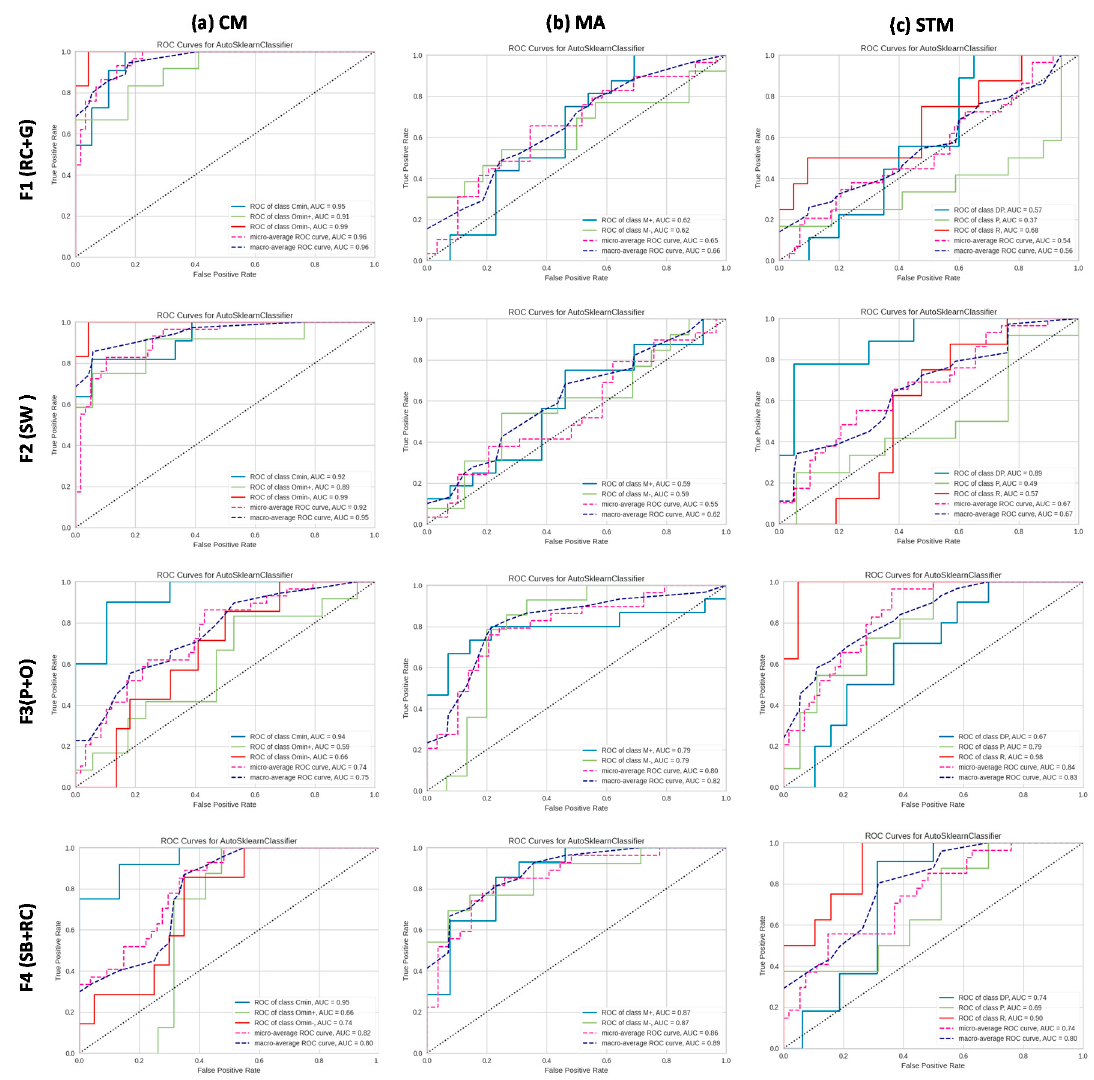
Figure 5. ROC curves and AUC of the AutoML classification corresponding to the subclasses within the AMPs for the acquisition of the UAS-VIs DN in May. From left to right, the ROC curves computed on ( a ) CM (Cmin+ (blue lines), Omin+ (green lines), Omin − (red lines)); ( b ) MA [M+ (blue lines), M − (green lines)]; ( c ) STM (DP (blue lines), P (green lines), R (red lines)); and their micro (pink dotted line) and macro (dark blue dotted line) average performance. Four crop categories (F1–F4) from top to bottom.